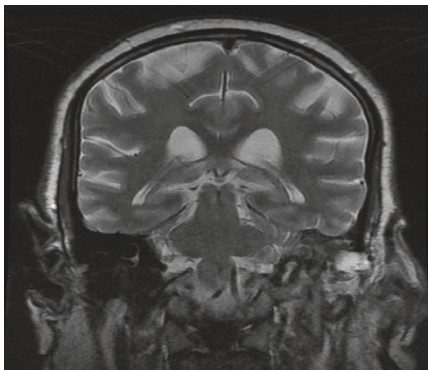
Figure 1: High-resolution CTscan (axial cut) of the temporal bone. Total opacification of the left-sided hypo- and mesotympanum by a soft tissue density. Mastoid air cells totally opacified with re- sorption of septae and partially sclerosed bone. Partial dehiscence of the mastoid portion of the facial nerve canal. The left tympanic membrane is thickened and retracted inwards. The left middle ear ossicles and scutum are intact. Normal aeration of the external auditory canals with intact bony and cartilaginous boundaries. The right middle ear cavity is normally aerated with intact ossicles. The right mastoid air cells are unremarkable.